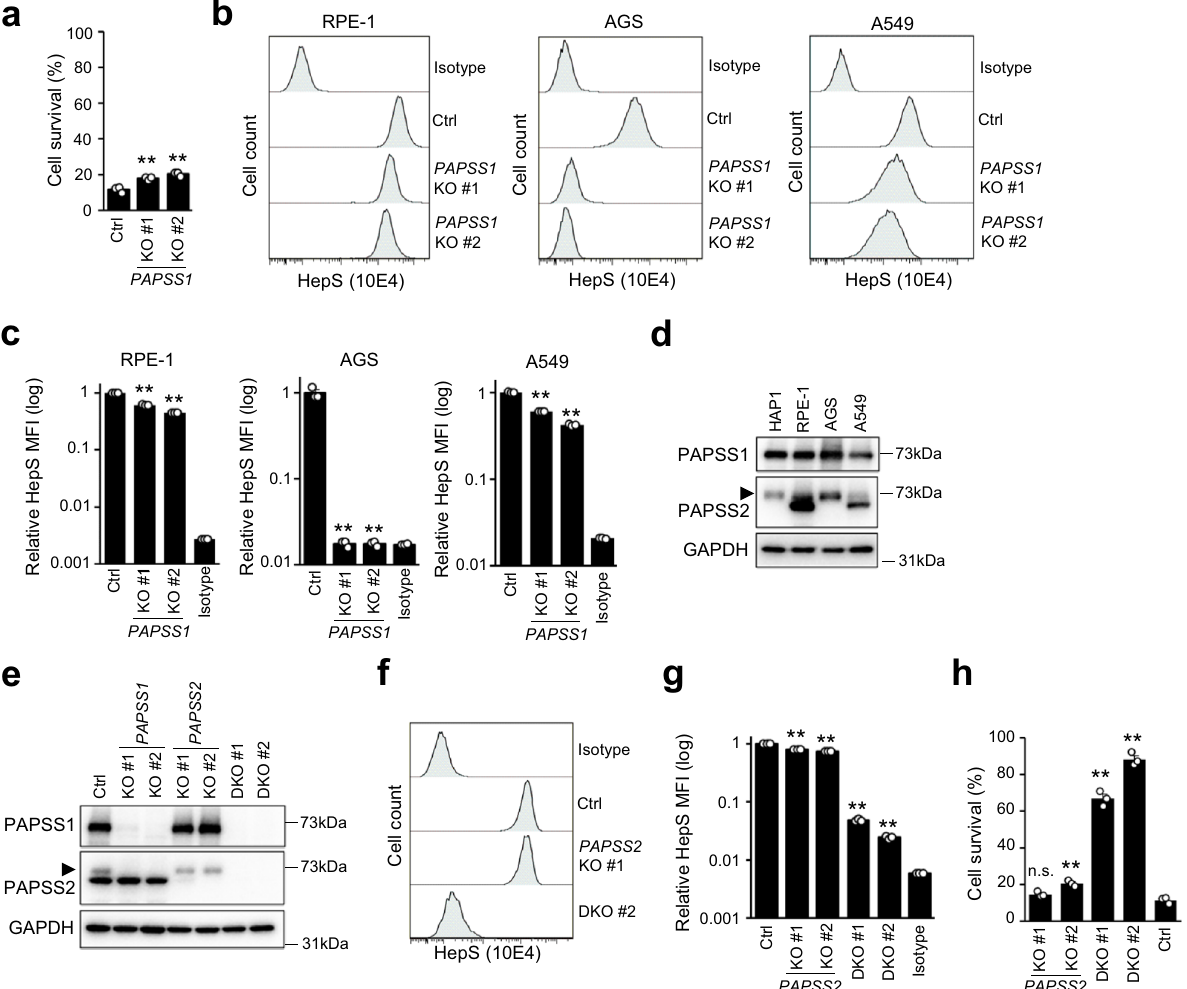
Fig. 5 PAPSS1 -dependency of HepS biosynthesis differs between cell lines due to the PAPSS2 expression. a Cell viability of PAPSS1 - KO of RPE-1 cell clones after HSV-1 infection. The cells were infected with HSV-1 at a MOI of 9. Their cell viabilities were measured using the MTS assay at 48 hpi. The results are presented as means± SEM of three independent experiments. b , c HepS expression analysis of PAPSS1 -KO clones of RPE-1, AGS, and A549 cells by FACS ( b ). The graph summarizes the MFI of the HepS expression analysis of three independent experiments ( c ). The results are presented as means ± SEM. d Western blotting showing the expression of PAPSS1 and PAPSS2 in HAP1, RPE-1, AGS, and A549 cells. The arrowhead indicates the cross- reactive band of PAPSS1. e Western blotting con fi rming the absence of PAPSS1 and/or PAPSS2 expression in the KO clones of RPE-1 cells. The arrowhead indicates the cross-reactive band of PAPSS1. f , g HepS expression analysis of PAPSS2 -KO and PAPSS1- and PAPSS2- double KO (DKO) clones of RPE-1 cells by FACS ( f ). The graph summarized the MFI of HepS expression analysis of three independent experiments ( g ). The results are presented as means ± SEM. h Viability of PAPSS2 -KO and DKO clones of RPE-1 cells after HSV-1 infection. The cells were infected with HSV-1 at an MOI of 9. The cell viabilities were measured by the MTS assay at 48 hpi. The results are presented as means ± SEM of three independent experiments. Double asterisks, p < 0.01; n.s. not signi fi